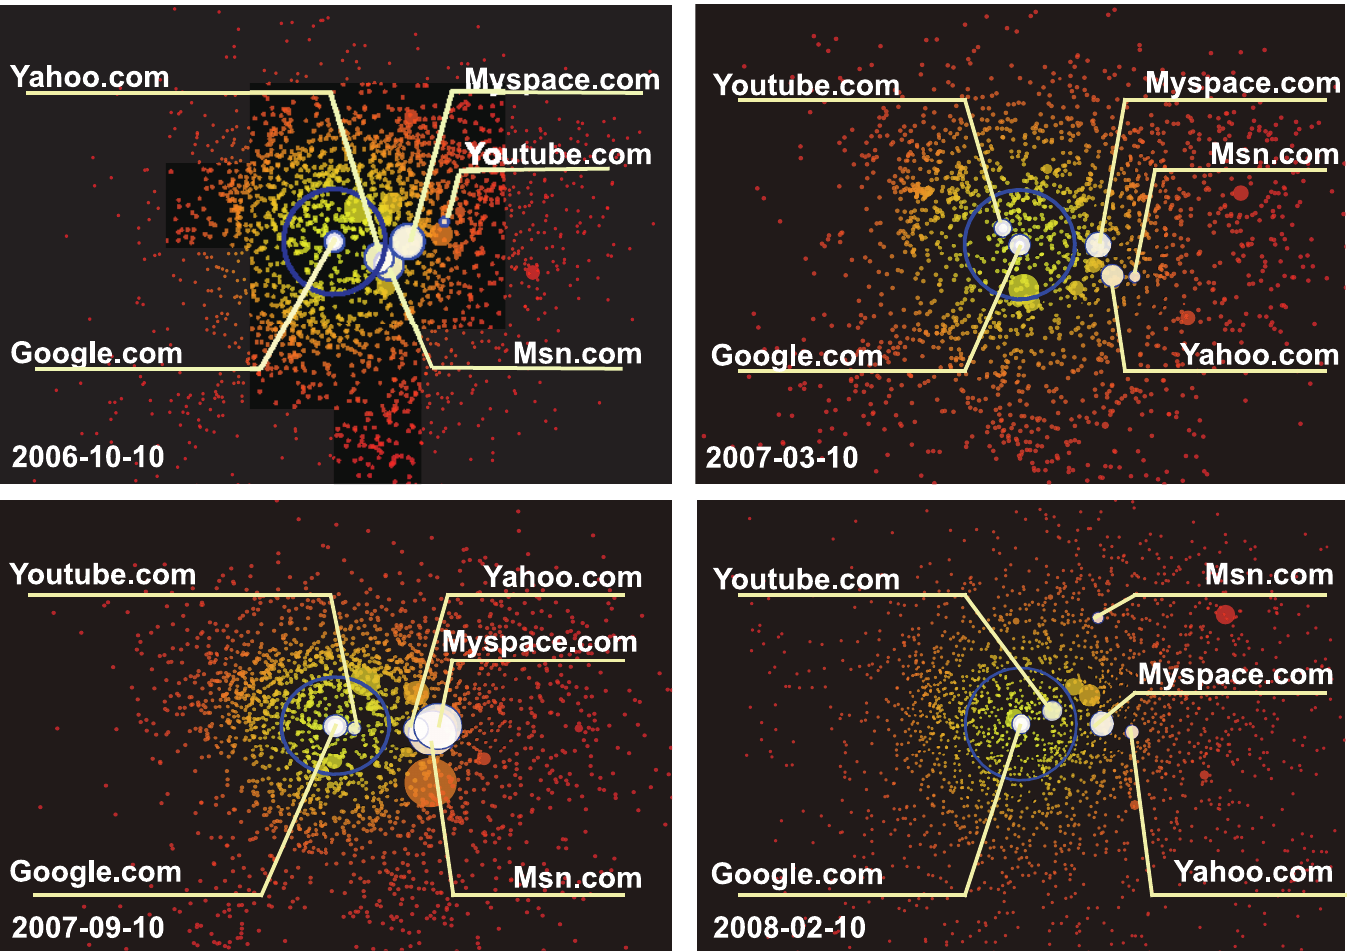
Fig 7. The snapshots of the geometric representations of the top 2200 websites in different days. The nodes of Google.com, Yahoo.com, Msn.com, Myspace.com and Youtube.com are highlighted. The radius of the blue circle is 1 which marks the central part of these